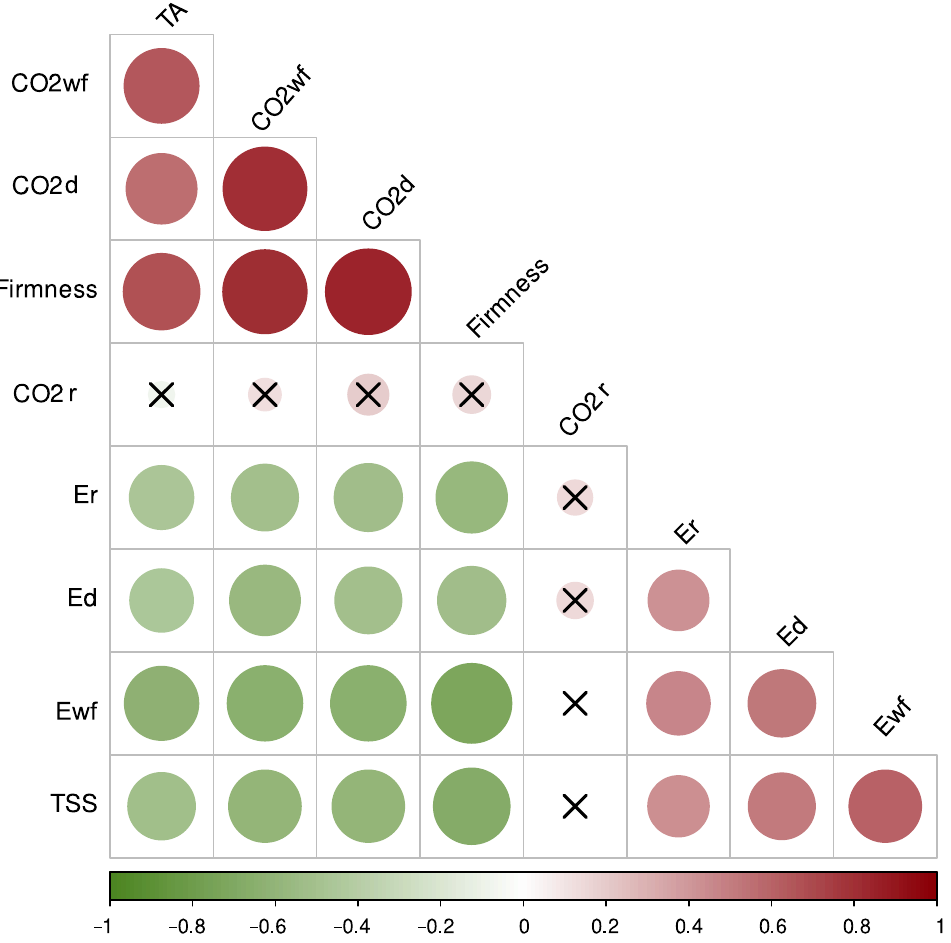
Figure 5. Correlation matrix of variables during raspberry (Rubus idaeus ‘Heritage’) fruit develop- ment. The correlation was carried out by Kendall’s method and on non-grouped data. Ewf: ethylene production in whole fruit; Ed: ethylene production in drupelets; Er: ethylene production in the receptacle; CO 2 wf: ethylene production in whole fruit; CO 2 d: ethylene production in drupelets; CO 2 r: ethylene production in the receptacle; TSS: total soluble solids content; and TA: titratable acidity.